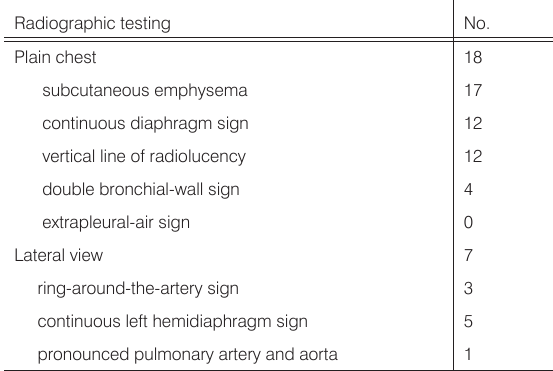
Table 3. Radiographic examinations